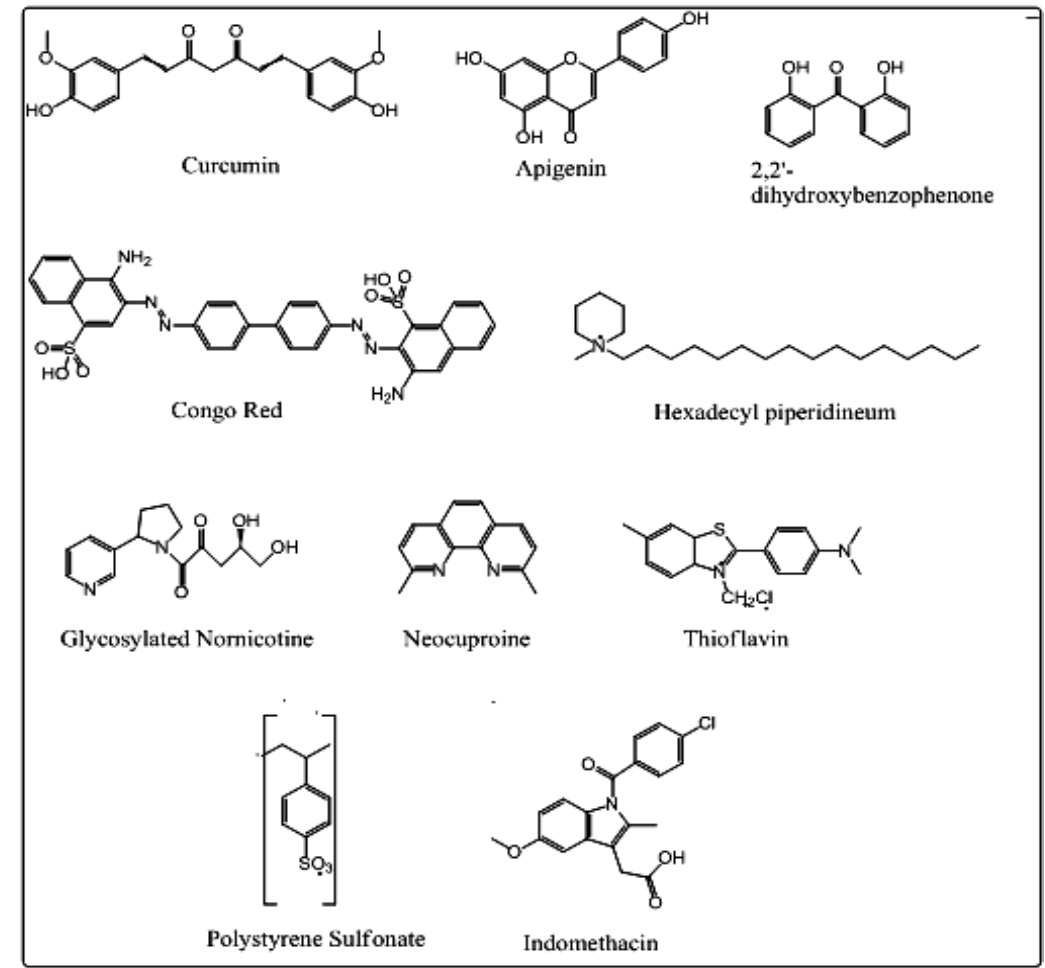
Figure 14. Neuroprotective Entities (NEs) employed in this study for modeling